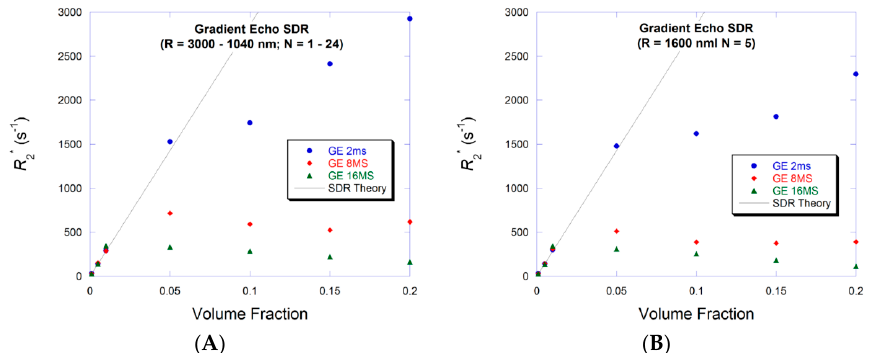
Figure 8. R 2 * values are plotted vs. particle volume fraction for particles within MAR. ( A ) The particle size is increased while the radius is decreased to achieve increasing volume fraction; ( B ) The particle size and radius are kept constant while the sample space is decreased to achieve increasing volume fraction. R 2 * values are flattened or saturated especially for the higher two echo-times values. SDR R 2 theory overestimates R 2 simulated values.